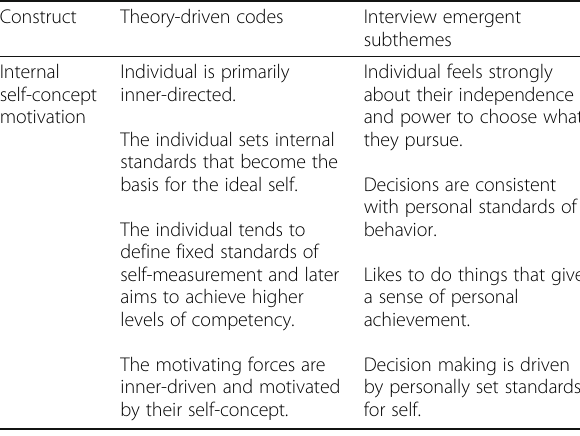
Table 4 Emergent themes related to internal self-concept